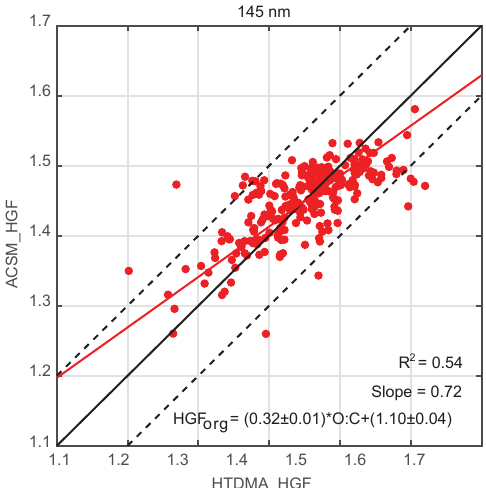
Figure 10. Closure analysis with the best fitting between the mea- sured HGFs and the ACSM-derived ones, using the O : C-dependent HGF org for 145nm particles. The assumption of size-dependent chemical composition of aerosols was considered to determine the ACSM-derived HGFs. The equation is the achieved approximation for HGF org as a function of the O : C ratio of organic aerosol frac- tion.